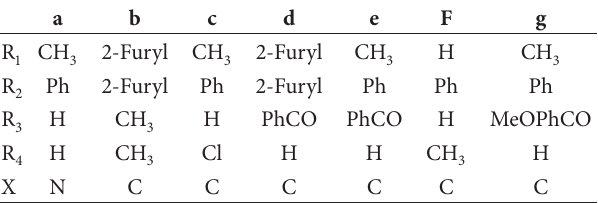
In an effort to develop potent antimicrobial agents, Ghadage and Shirote [16] have synthesized some substituted quinoxalin-2(1H)-one derivatives. Final derivatives 14a – e (Figure 7) were screened for their in vitro antibacterial activity against range of Gram positive and Gram-negative; also for their anti-fungal activity against a strain of Candida albicans species. It was found that all the selected com- pounds exhibit wide antimicrobial activity. Amongst these compounds, compound 14b was highly active against E. coli . against P. aeruginosa and S. aureus . The compounds 14c